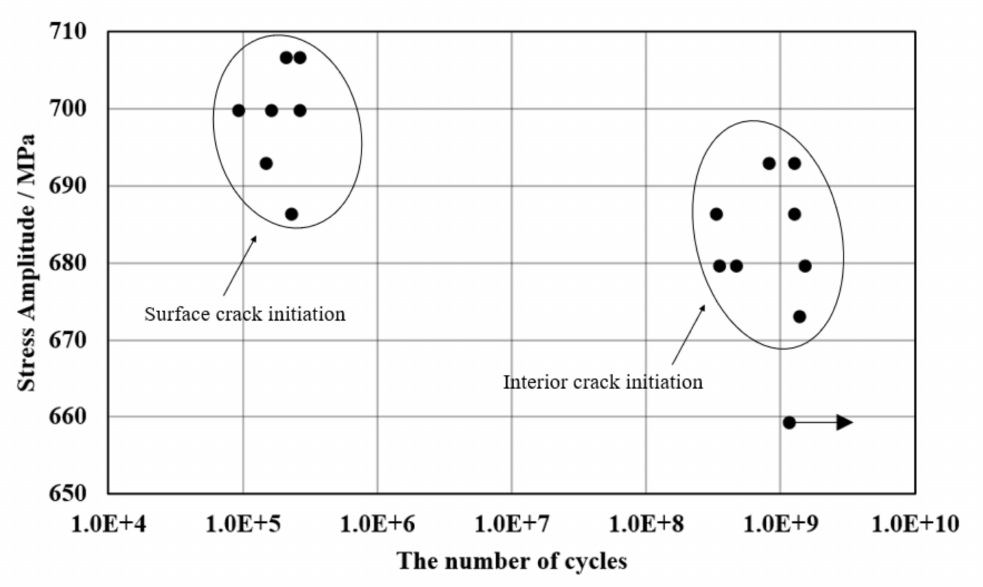
Figure 4. VHCF fatigue strength of Inconel